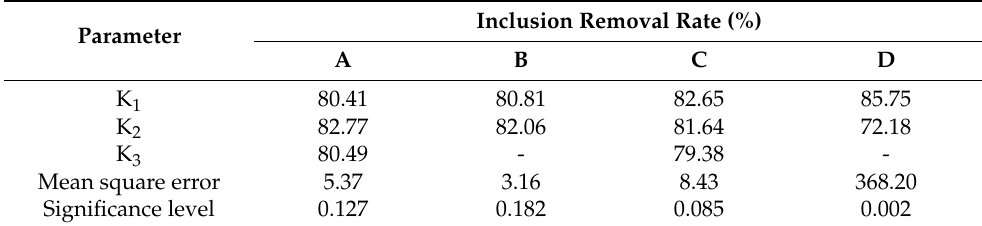
Figure 12. Stacked histogram of removal rate of fine inclusions. Table 5. The range and variance of the removal rate of fine inclusions in different schemes. Parameter